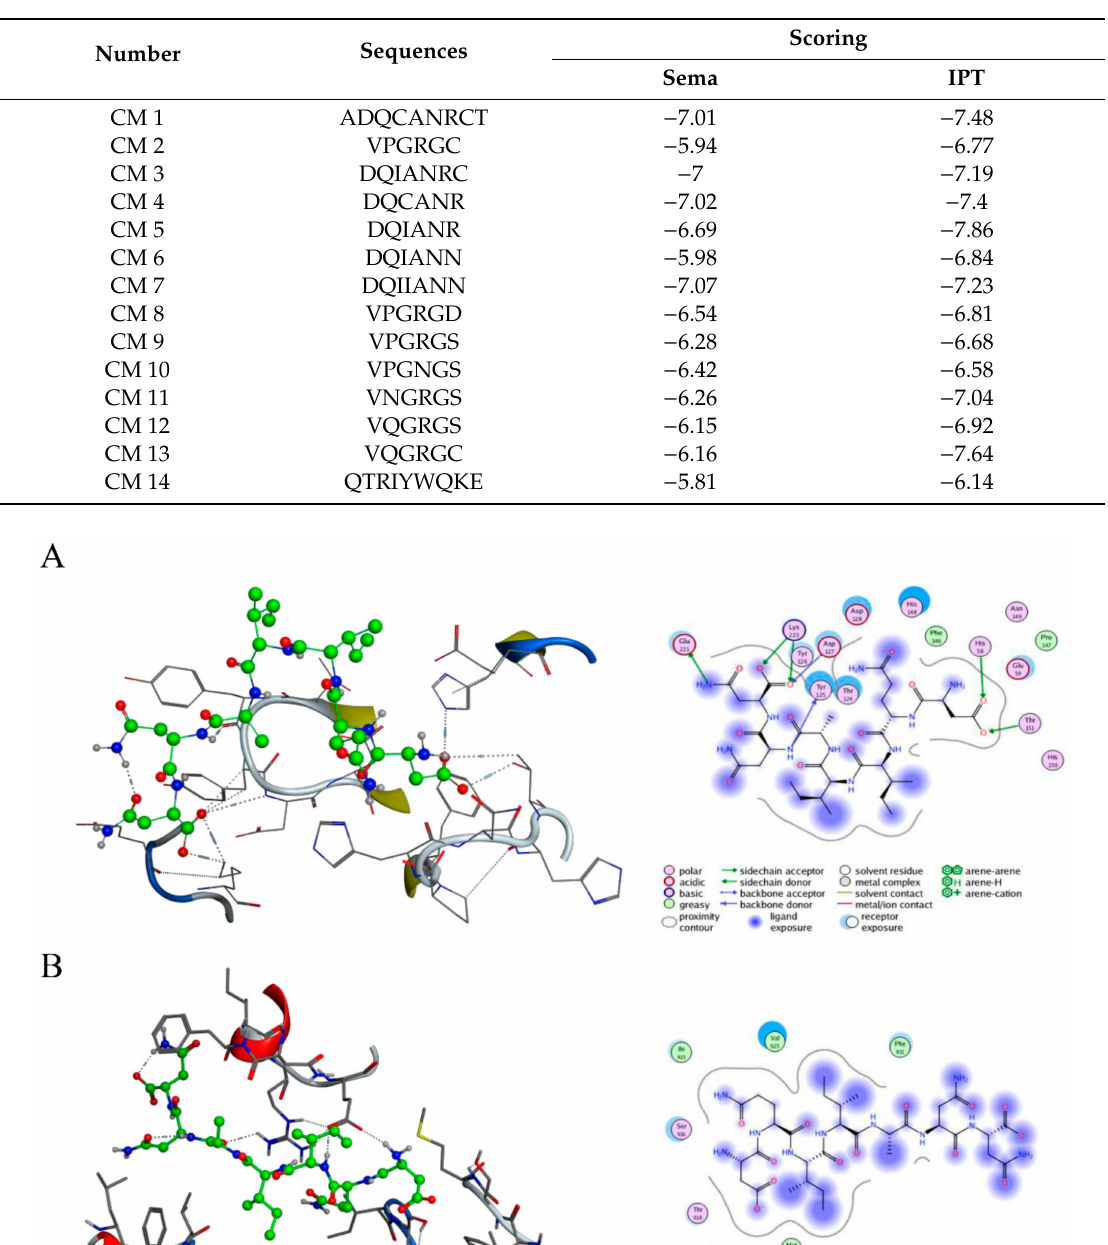
Table 1. Virtual screening of c-Met and designed peptides.